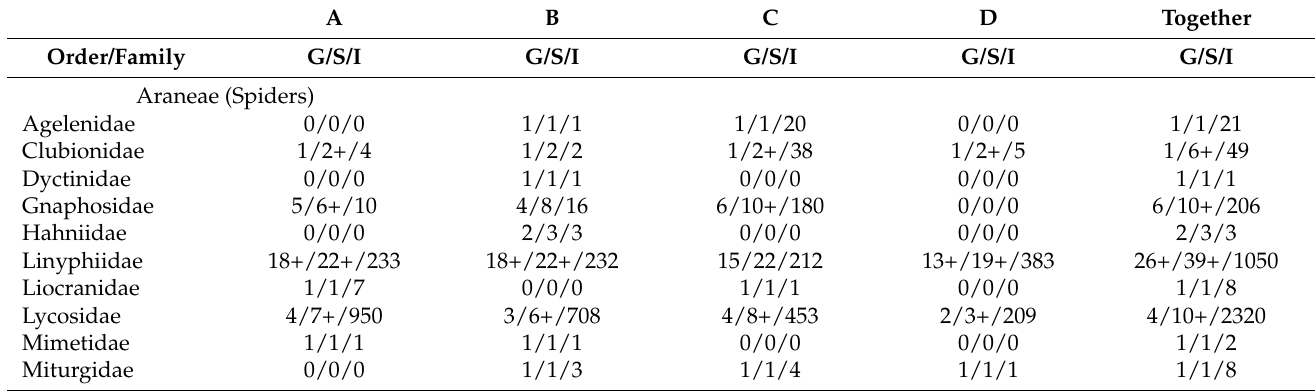
Table 1. Summary of obtained epigeic groups of predators. A—starting colony; B—dense active colony; C—abandoned colony; D—control pine forest without cormorants; G/S/I—number of